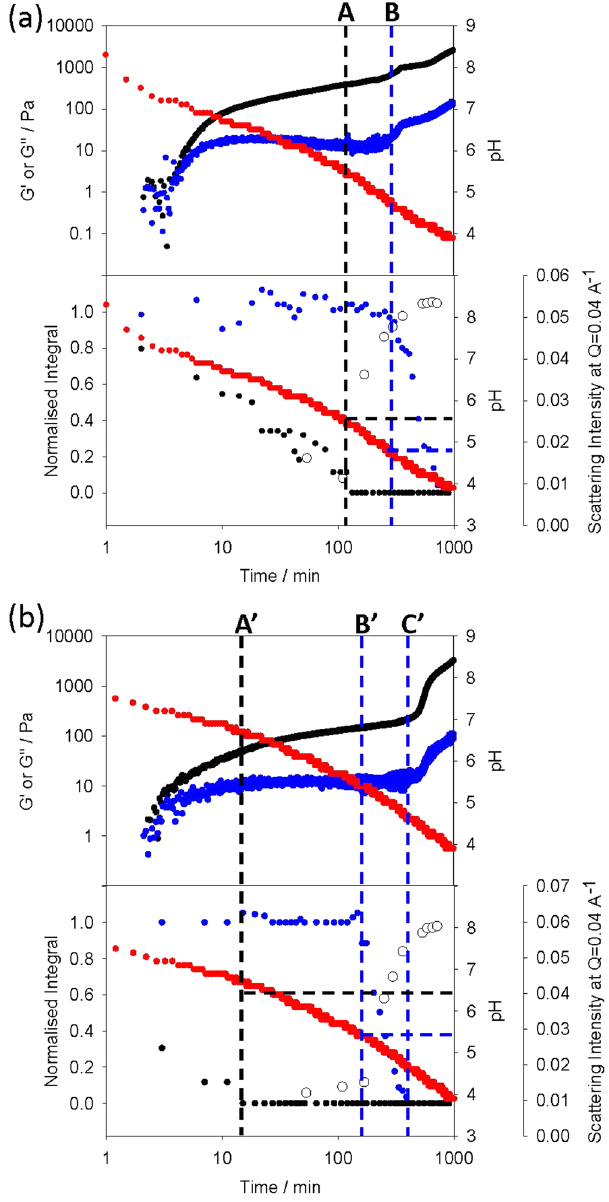
Figure 3. Plots showing the evolution of the gel networks of the two component systems with time, monitored with different techniques: ( a ) 1 + 3 , ( b ) 2 + 3 . For ( a ) and ( b ), the top plots show the evolution of pH (red data) and rheological moduli (G ′ , black; G ″ , blue). The bottom plots show the evolution of pH (red data), integral of 1 H NMR signals due to CH groups in 1 (black in ( a )), 2 (black in ( b )) and 3 (blue in ( a) and ( b )), and SAXS (open circles). Note that the scatter of the NMR data is attributed to the inherent inaccuracy of integrating broad NMR signals (see Fig. S3 Supporting Information). The normalised value was determined from the integration of the components against the internal standard at pD 11 before the addition of